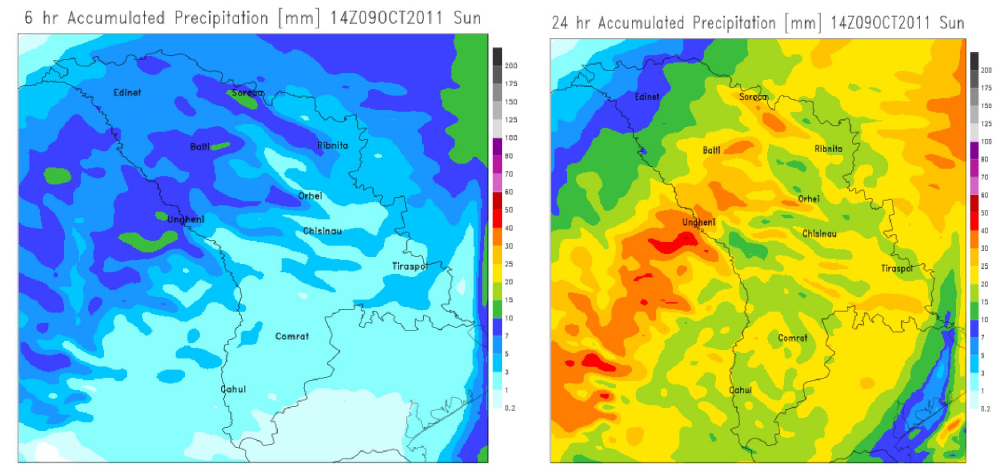
Figure 15. Accumulated rain (6 and 24 hours), forecasted by MM5 weather forecast model over Moldovan territory . Fig. 15. Accumulated rain (6 and 24h), forecasted by MM5 weather forecast model over Moldovan territory.